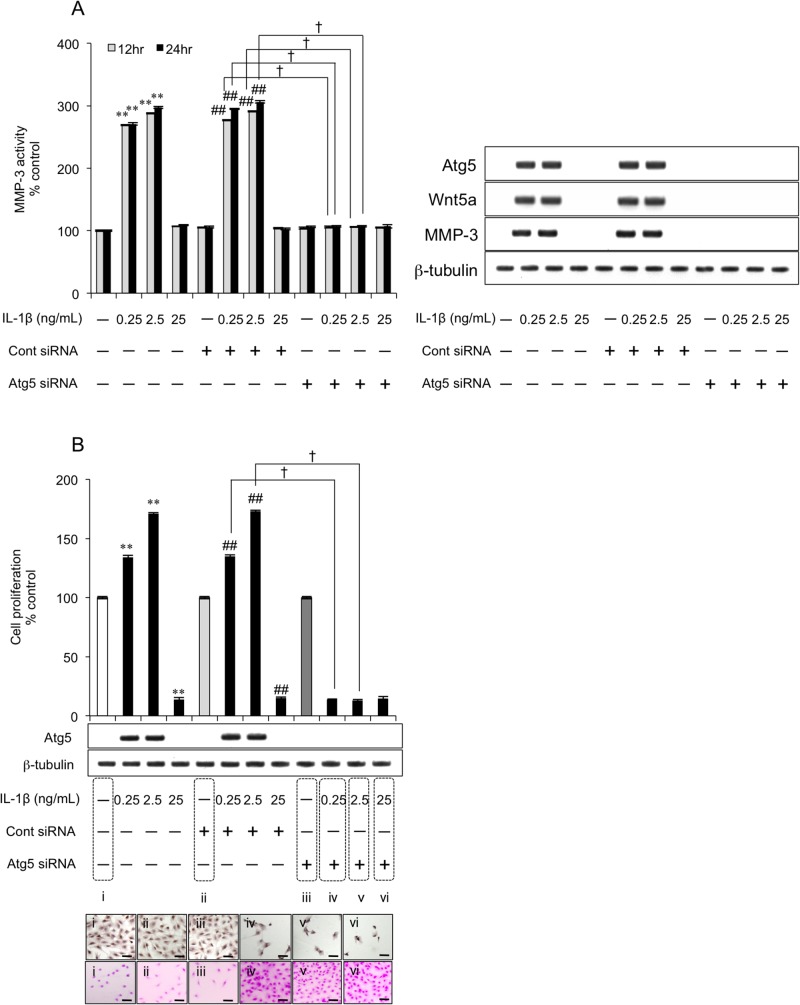
Effect of Atg5 siRNA on IL-1β-induced MMP-3 activity and cell proliferation.(A) E14Tg2a ES cell-derived odontoblast-like cells were transfected with Atg5 siRNA for 24 h and treated with IL-1β (0, 0.25, 2.5 and 25 ng/mL) for either 12 h (grey bars) or 24 h (black bars), prior to carrying out an MMP-3 activity assay (left) and western blotting for Atg5, Wnt5a and MMP-3 (right). (B) Results of the BrdU-cell proliferation ELISA (for cell proliferation; graphs), BrdU Immunohistochemistry Kit (for cell proliferation; images, upper row), and APOPercentage Apoptosis Assay kit (for apoptosis; images, lower row) are shown. β-Tubulin was used as a housekeeping protein in western blots. **P < 0.01 vs. control; ##
P < 0.01 vs. control siRNA; †
P < 0.01, as indicated by the bracket. The BrdU ELISA kit stains the nuclei of proliferating cells dark brown. Accumulation of dye (pink-purple) denotes apoptosis in the APOPercentage kit. Images are representative of at least three independent experiments. Scale bars = 100 μm.